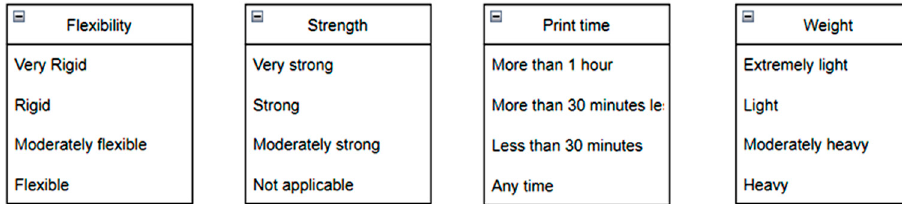
Figure 10. Questionnaire . Figure 10.